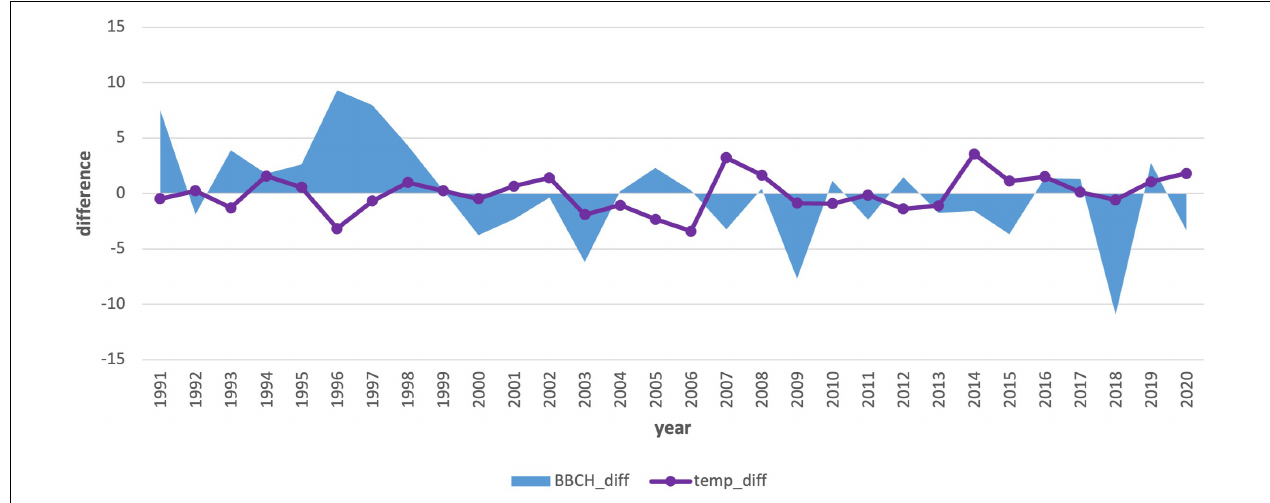
FIGURE 10 | Comparison of the average 3-month air temperature deviations from January to March with the deviations in the onset of the phenological phase from the long-term average from 1991–2020.